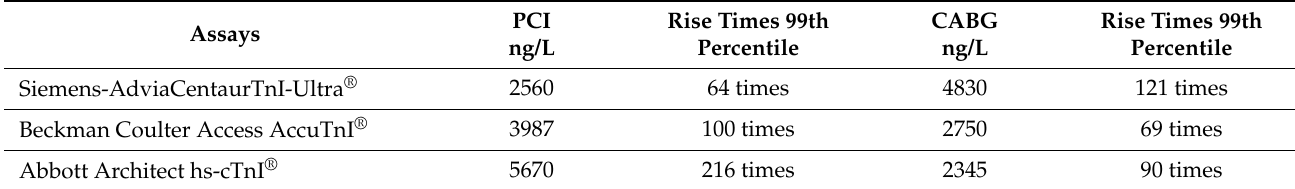
Table 3. cTnI rise times 99th percentile in patients submitted to PCI and CABG.